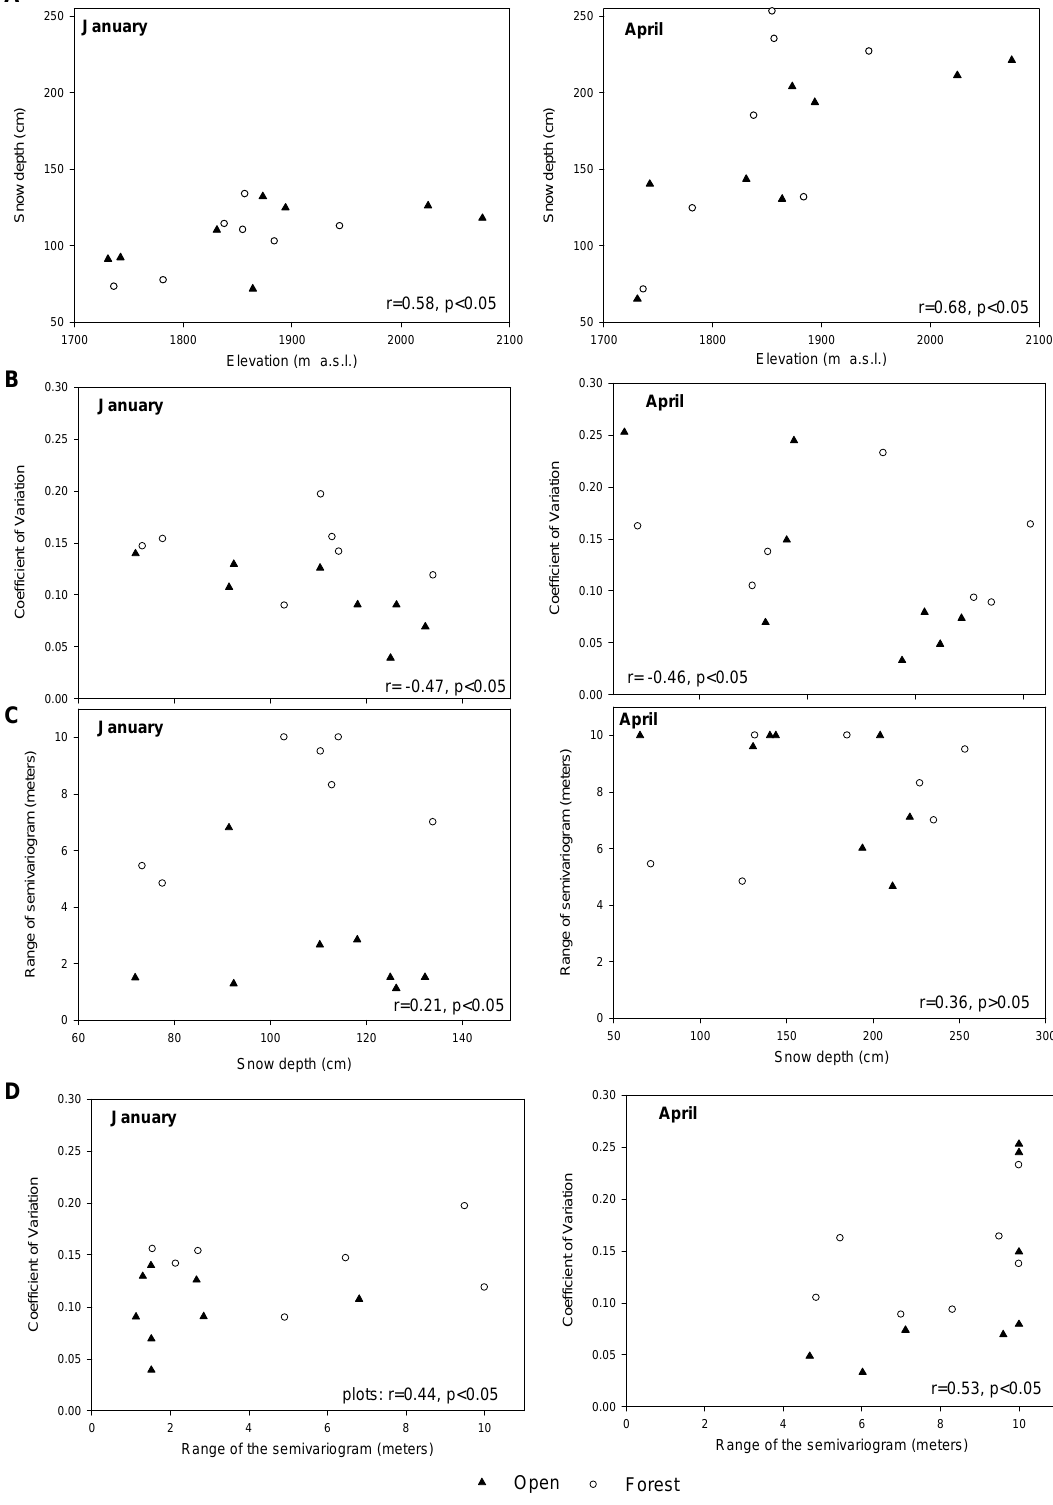
Figure 3. 4 Fig. 3. Relationships between (A) snow depth and altitude, (B) snow depth and coefficient of variation, (C) snow depth and semivariogram range, and (D) coefficient of variation and semivariogram